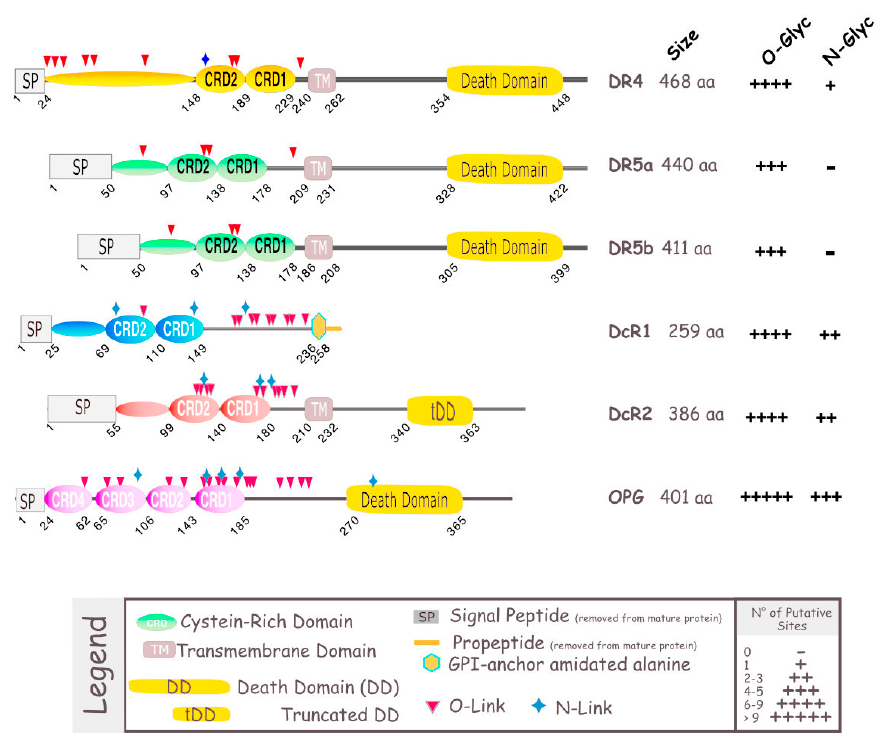
Figure 1. Schematic representation of TRAIL receptors. TRAIL-R1/death receptor 4 (DR4), TRAIL-R2/death receptor 5 (DR5), act as agonistic receptors, owing to their intracellular death domain (DD), through which they transmit an apoptotic signal. The other two membrane receptors, TRAIL-R3/decoy receptor 1 (DcR1) and TRAIL-R4/decoy receptor 2 (DcR2), act as antagonistic/regulatory receptors, due to their lack of functional DD. Osteoprotegerin (OPG), contains a DD, but is unable to trigger apoptosis as it lacks a transmembrane domain (TM), and is therefore a soluble receptor. DR4 and DR5 have been found to be N - and O -glycosylated, respectively [22–24]. DcR1, DcR2 and OPG, alike, as most members of the TNF superfamily [37], contain putative glycosylation sites, which are depicted as blue stars or red triangle. The size of these receptors is shown on the right-hand side.